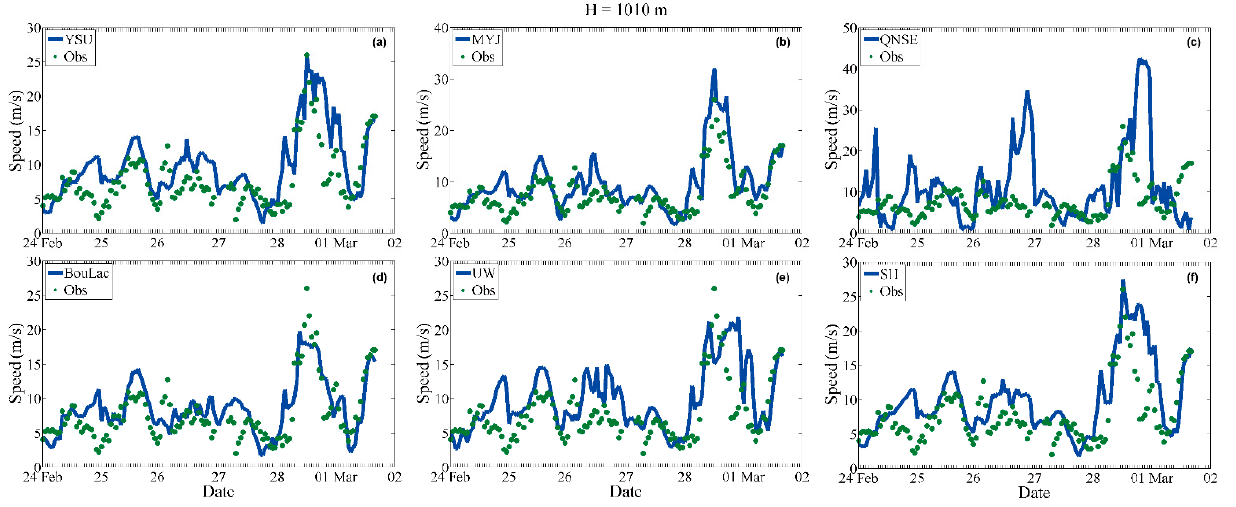
Figure 5. The observed and simulated wind speeds at a height of 1010 m with the PBL schemes of YSU, MYJ, QNSE, BouLac, UW and SH. Table 3. Under different conditions, the PBL schemes with low biases of wind speed and direction, large correlation coef- ficients, and close standard deviation on sunny days, hazy days and windy days, and at four wind speeds ranges (0–5, 5– 10, 10–15, over 15). The bias of suitable scheme in the table is below 20%. “—” Indicates poor simulation or no data. “All” means all the PBL schemes.